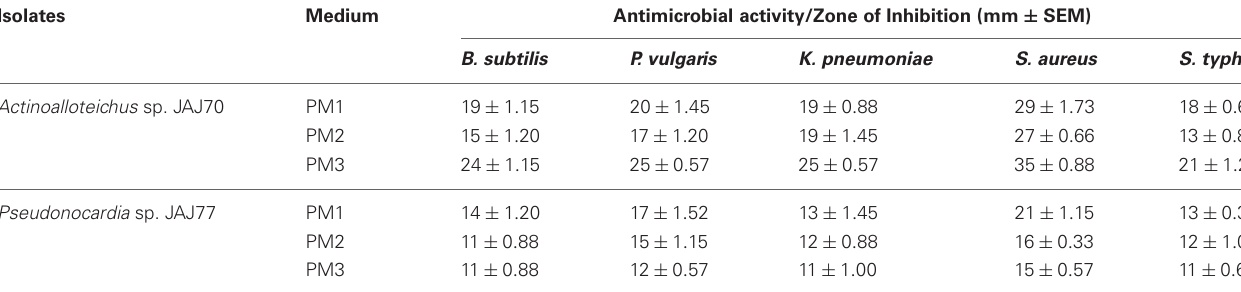
Table 2 | Antibacterial activity of saltern actinomycetes against five test bacteria. Isolates